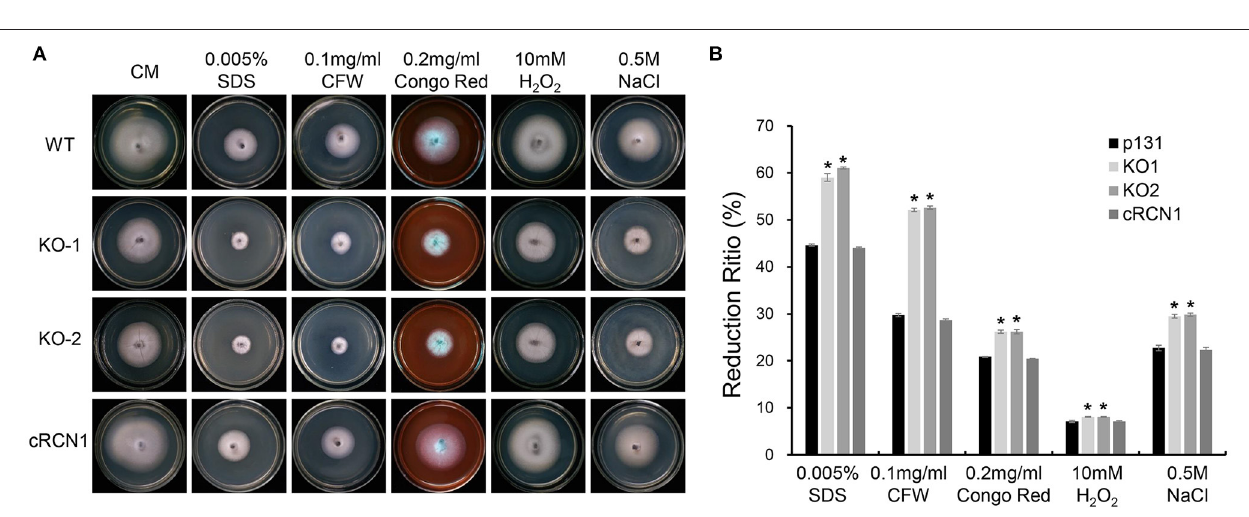
2 O 2 and 0.5M NaCl agents. The colonies